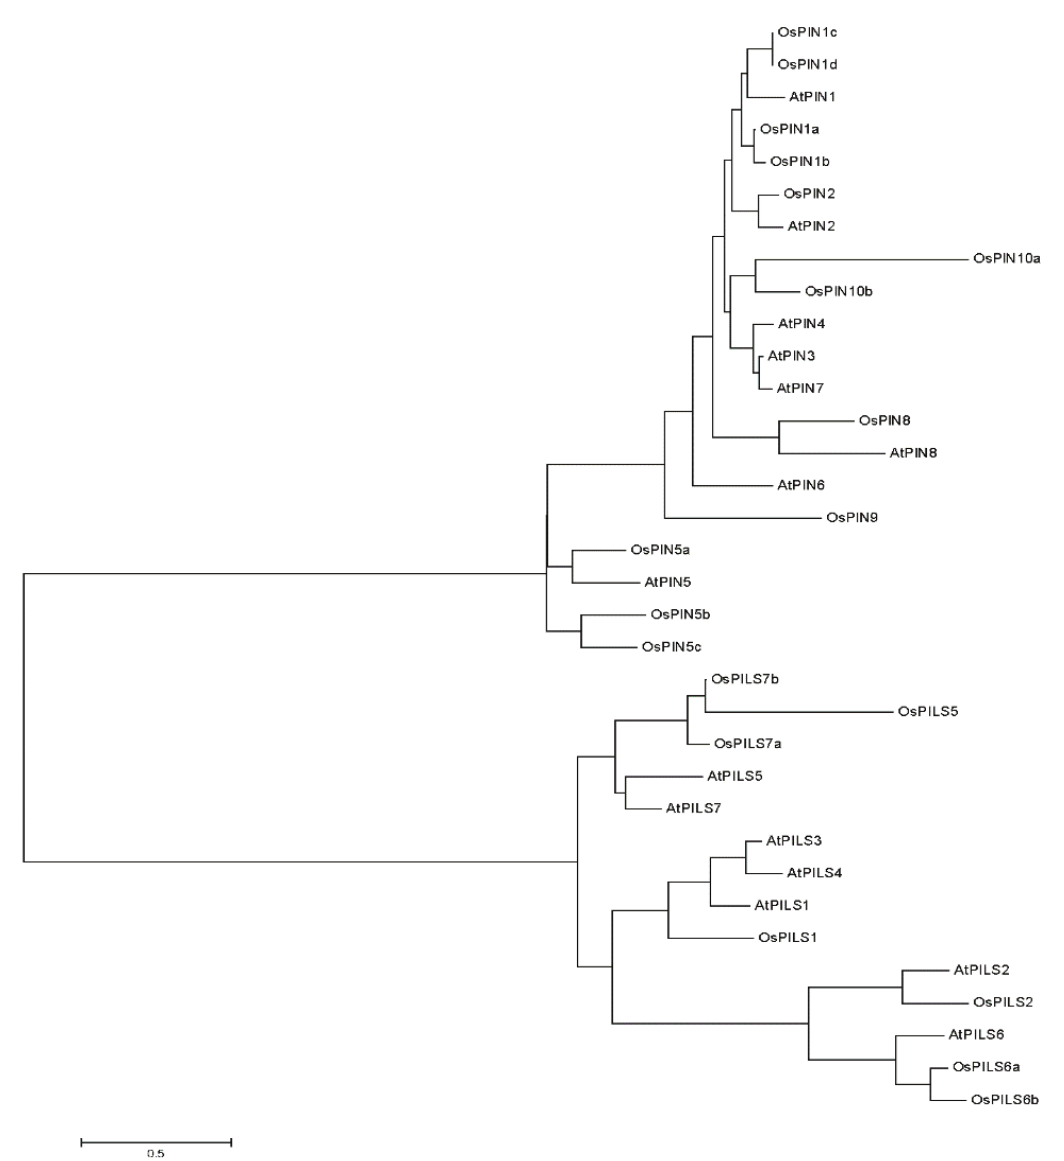
Figure 6. The phylogenetic tree of OsPIN, AtPIN, AtPILS and OsPILS genes. The phylogenetic analysis revealed PINs and PILS are grouped into two distinct clades. In the phylogenetic tree, the short transmembrane domain containing the OsPIN5 and AtPIN5 protein lies proximately towards the short transmembrane domain containing the AtPILS and OsPILS protein. These findings indicate that OsPILS proteins are short transmembrane domain containing